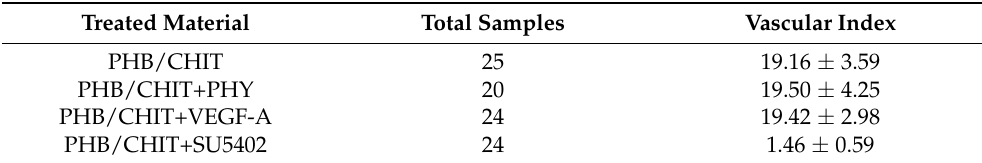
Table 1. The vascular index expressed as difference between number of vessels immediately after the implantation (ED7) and 72 h after the implantation of PHB/CHIT (ED10). Values are means ± SD of n = 3 independent experiments. Treated